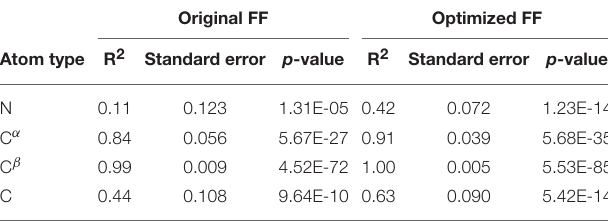
2012) approach, here we used the optimized FF parameters to TABLE 5 | Summary of the statistical significance in comparing NMR observed chemical shifts with the FF parameters (original and optimized) for PaaA2